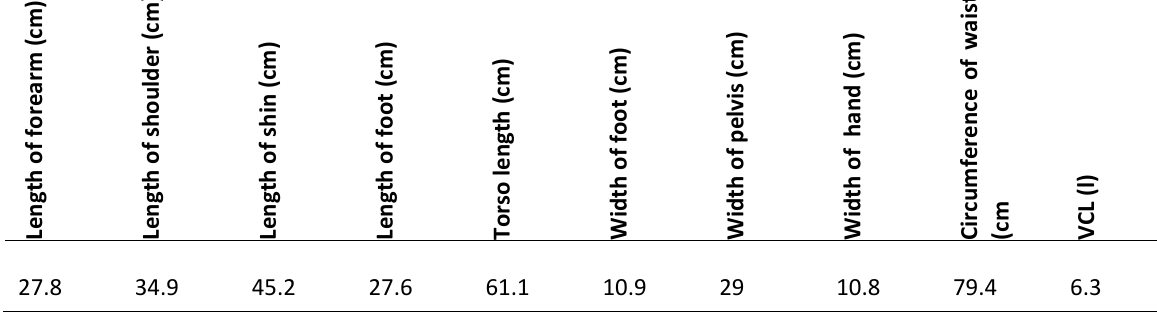
Table 4. Model morphological-functional characteristics for 200 meters’ breaststrokers